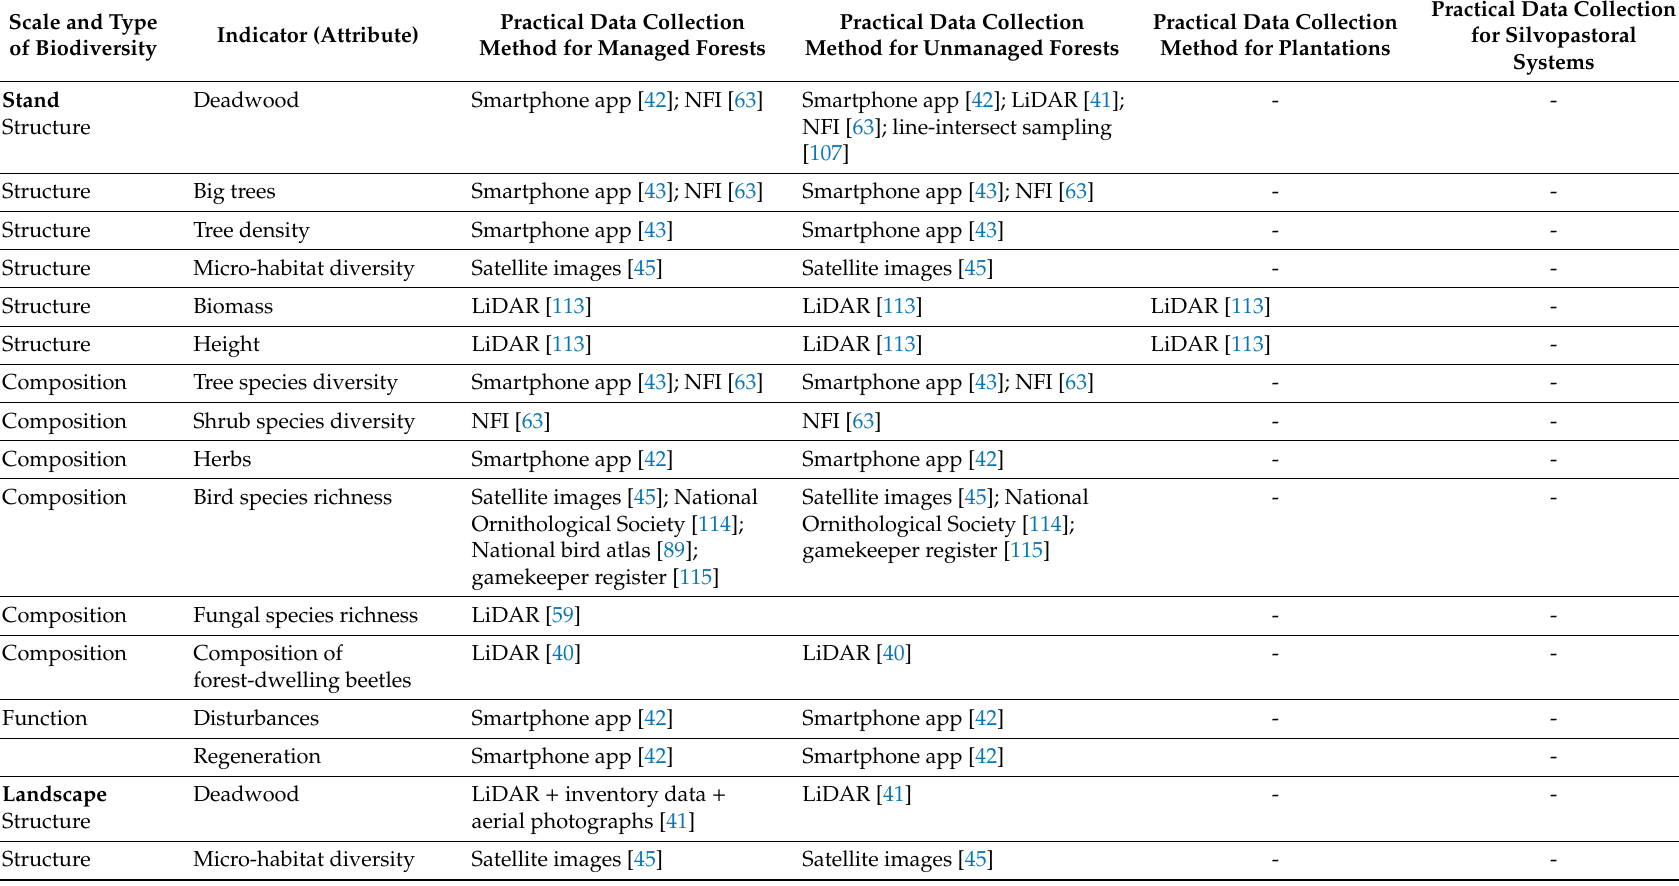
Table 3. Practical methods for data collection for di ff erent biodiversity attributes in three types of forests and types of biodiversity (structure, composition, and function) Note: not all the authors reported the types of forests clearly, and thus we put in the table information only about those which are clearly